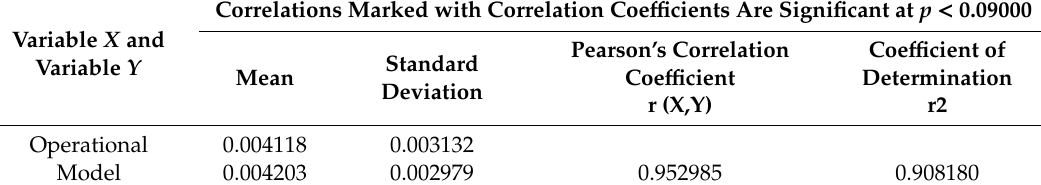
Table 5. Results of correlation analysis for the group of tested steels in medium soil.